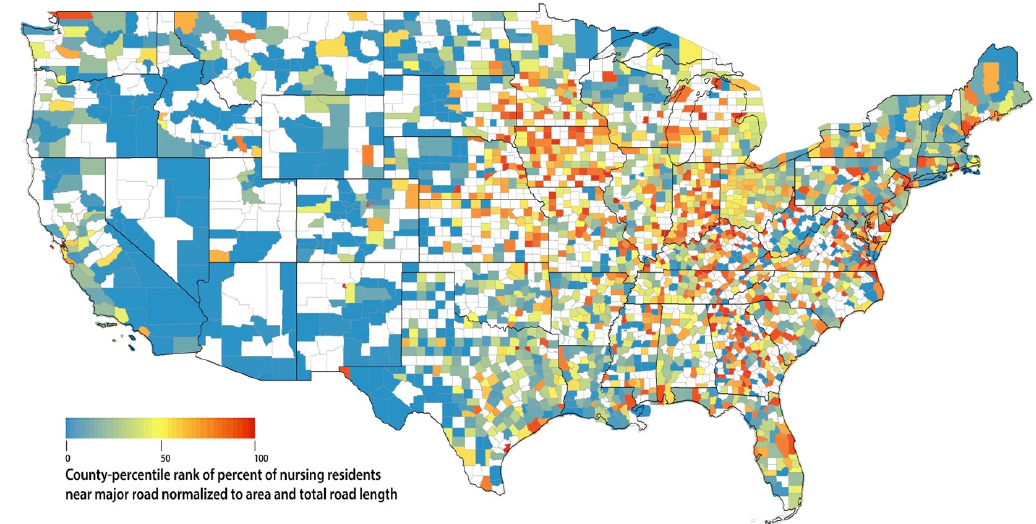
Figure 3. Percentile rank of percent of nursing residents near major road, normalized to county area and total length of major roadways within each county. Blank indicates no nursing resident near major road in that county.